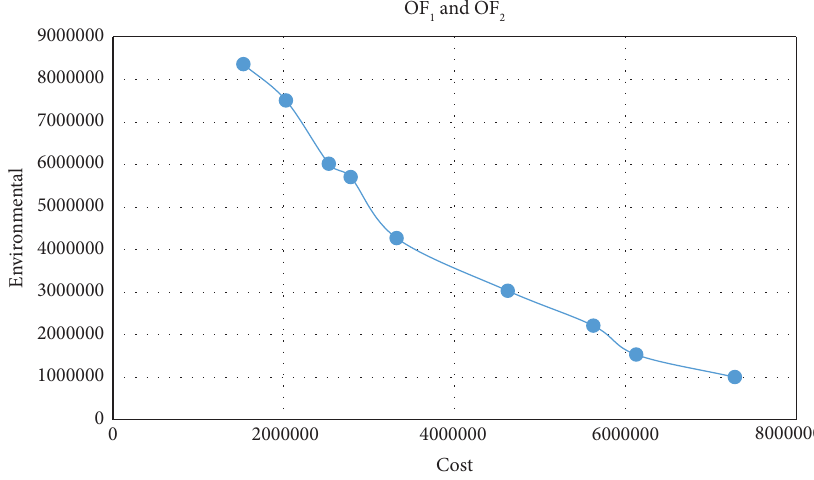
Figure 6: Pareto frontier of the numerical example.